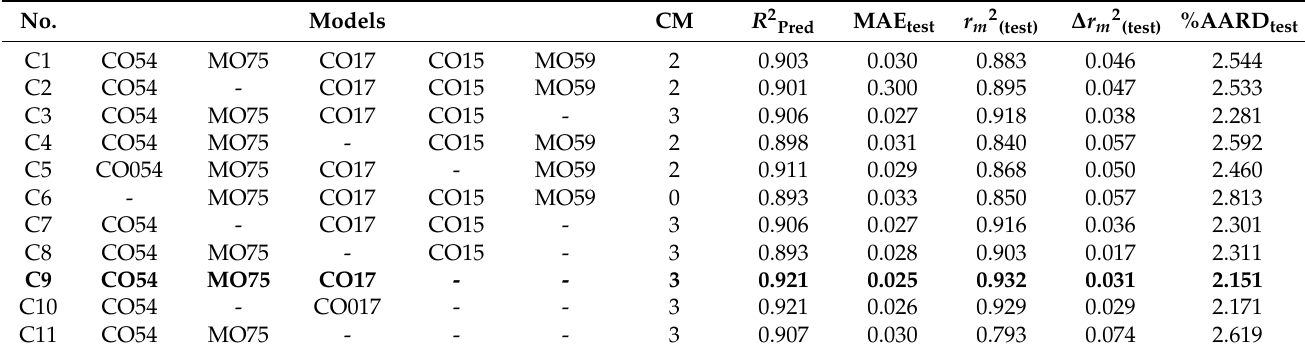
Table 5. Results obtained for the external validation set ( n = 207) by consensus prediction using the most significant QSPR models. The best consensus model is marked in